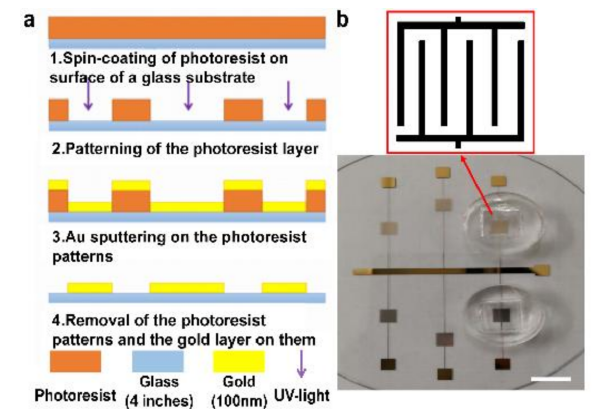
Figure 1. ( a ) Fabrication processes of the electric cell–substrate impedance sensing (ECIS)-based sensor. ( b ) Configuration of the prepared ECIS-based sensor. Scale bar = 1 cm.